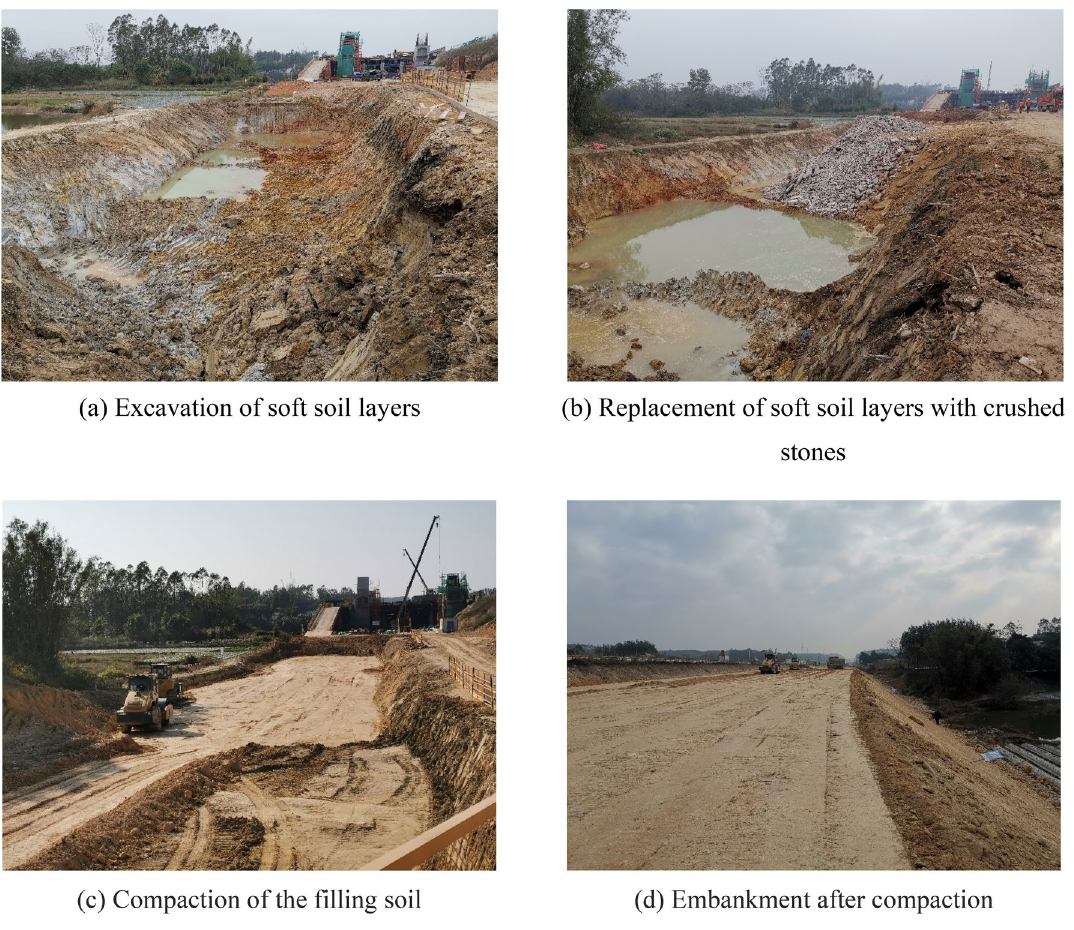
Figure 11. Weak soil replacement